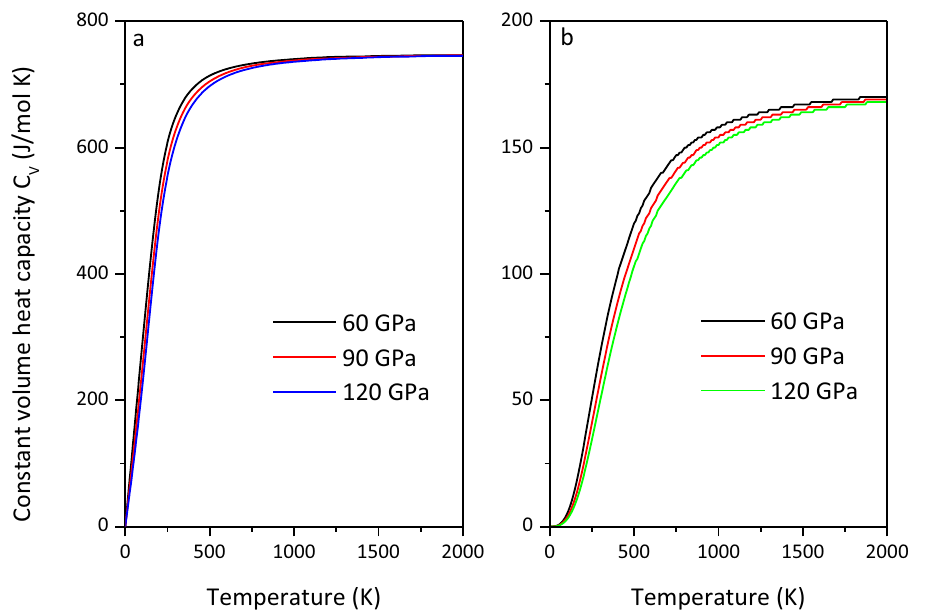
Figure 13. Constant volume heat capacity C V of MgCO 3 - C 2 /m ( a ) and Mg 2 CO 4 - P 2 1 /c ( b ).